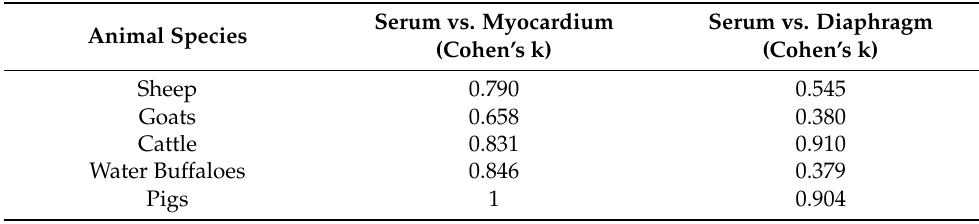
Table 5. Cohen’ k values obtained from the comparison of the T. gondii antibody detection using different serological matrices (i.e., serum, meat juice from myocardium, meat juice from diaphragm) from different livestock species. Serum vs. Myocardium Serum vs. Diaphragm Animal Species (Cohen’s k) (Cohen’s k) Sheep 0.790 0.545 Goats 0.658 0.380 Cattle 0.831 0.910 Water Buffaloes 0.846 0.379 Pigs 1